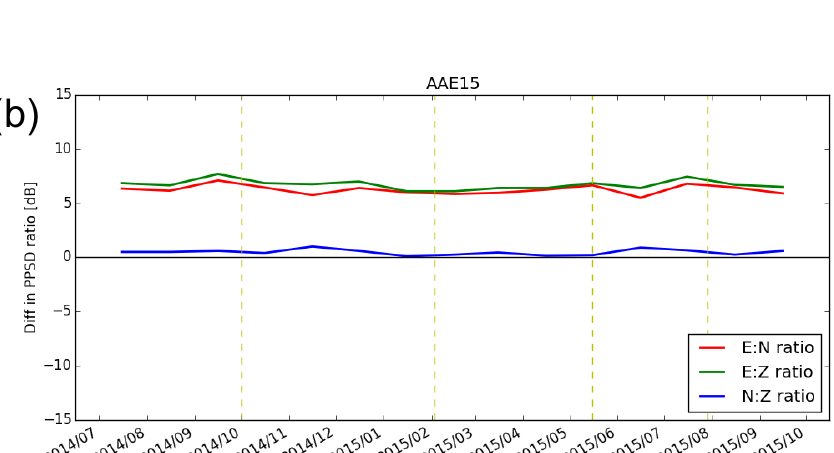
(Fig. 9b), or a comparison of noise levels in the vertical and horizontal components in PPSD. In the case of correct com- ponent identification, the noise level in the vertical compo- nent should be lower than that in the horizontal